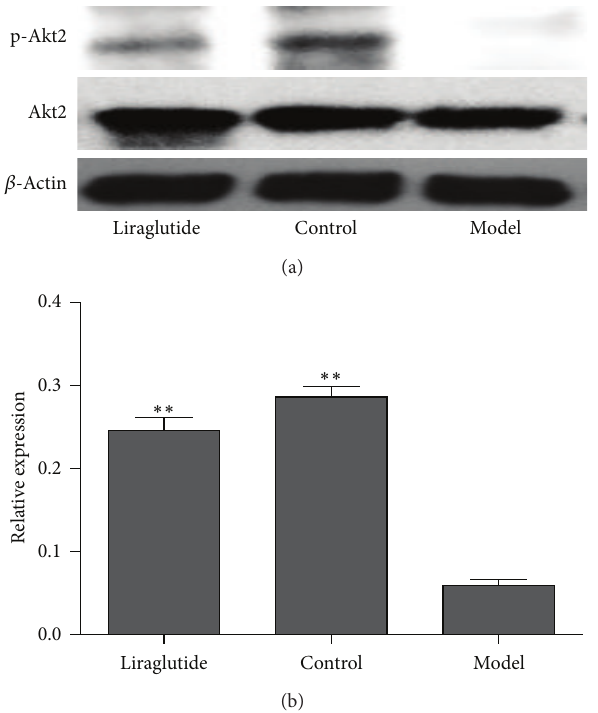
Figure 6: Effects of liraglutide on p-Akt2 and Akt2 expressions in skeletal muscle. (a) Expression in skeletal muscle of p-Akt2 and Akt2 mRNA in normal, model, or liraglutide group. Gene expression was measured by RT-PCR. Relative p-Akt2 and Akt2 mRNA abundance was normalized by 𝛽 -actin. Data were shown as mean ± SD, ∗ 𝑃 < 0.05 , ∗∗ 𝑃 < 0.01 versus model group, 𝑛 = 5 . (b) Expression of p-Akt2 and Akt2 protein in skeletal muscle from normal, model, or liraglutide group. Lysates from freshly isolated skeletal muscle tissues were measured for p-Akt2 and Akt2 expression by Western blot analysis. Results were shown as mean ± SEM, ∗ 𝑃 < 0.05 , ∗∗ 𝑃 < 0.01 versus model group, 𝑛 = 5 .